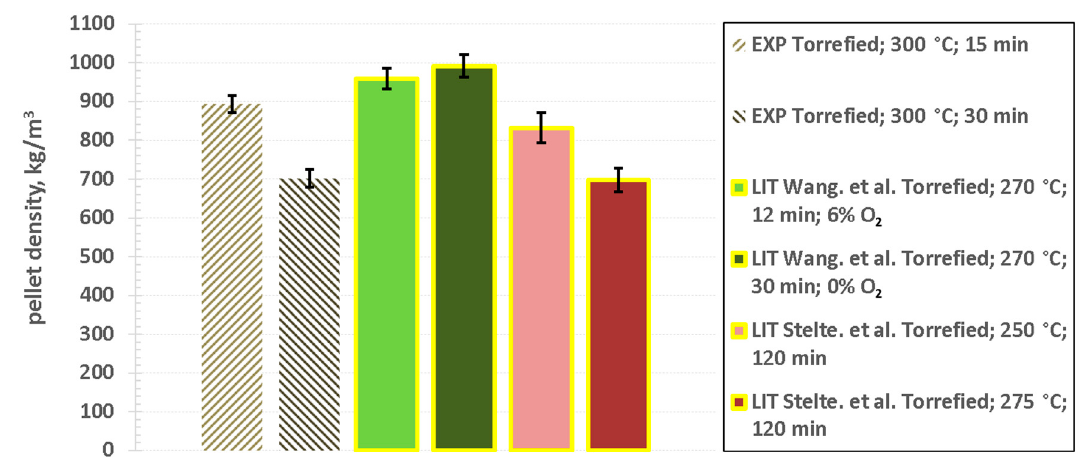
Figure 2. Density of the pellets pressed using torrefied sawdust, in comparison to results published in the literature [77,97]; (LIT – results from the literature; EXP – experimental results obtained in this study).